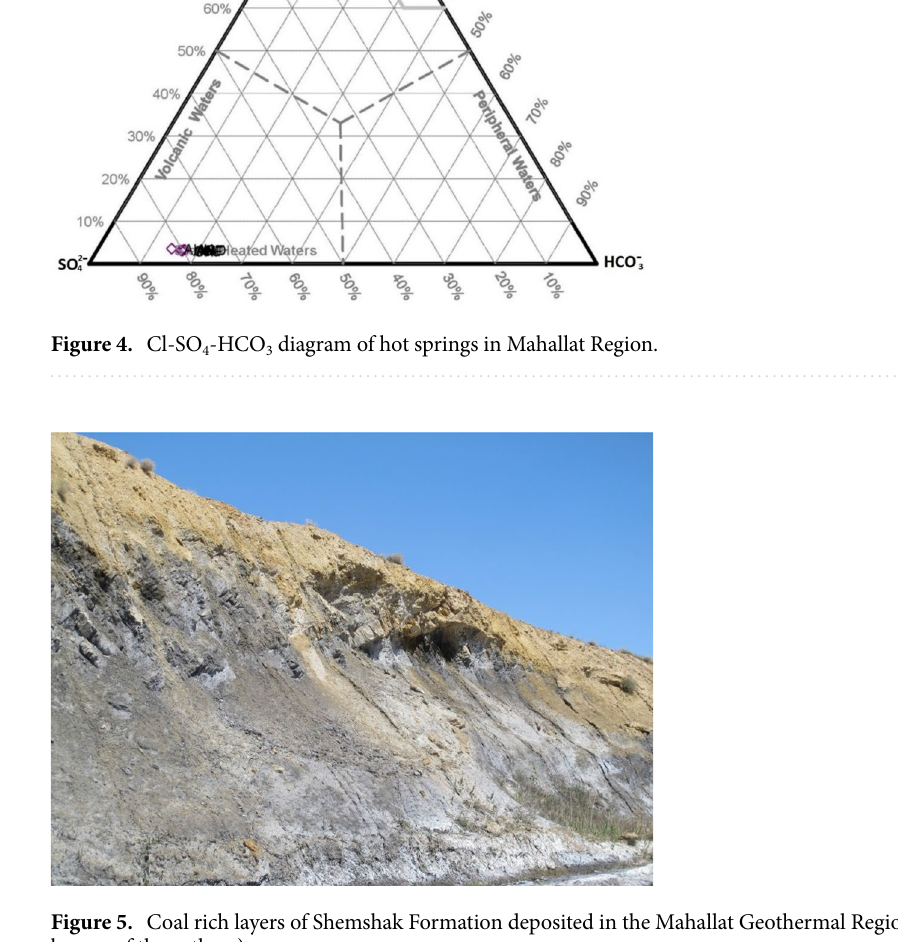
Figure 5. Coal rich layers of Shemshak Formation deposited in the Mahallat Geothermal Region (photo taken by one of the